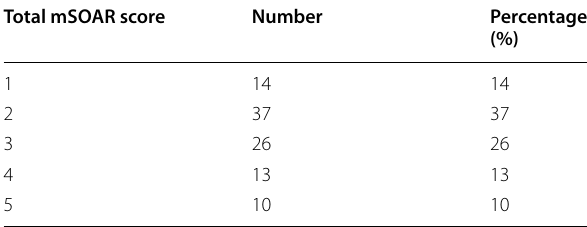
Table 2 Total mSOAR score